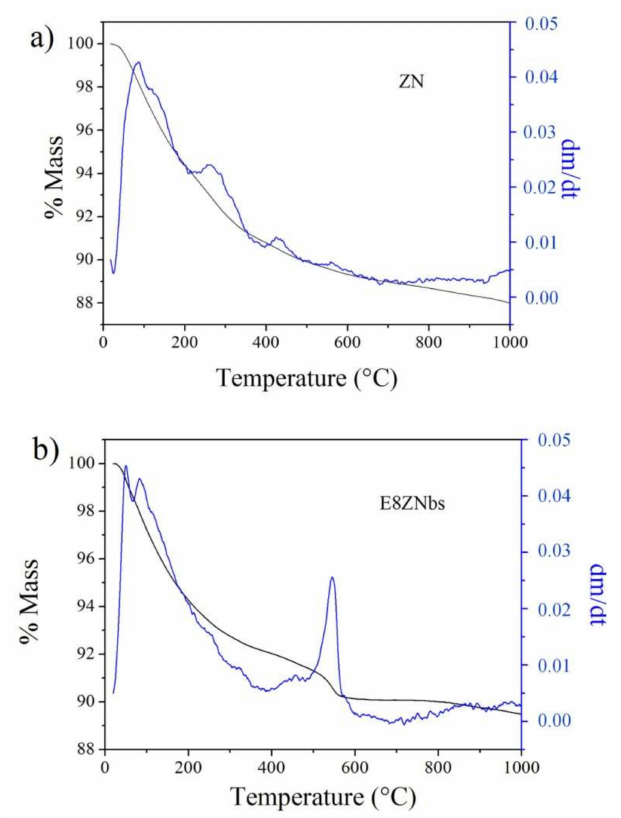
Figure 10. Thermogravimetric analysis of the ( a ) natural sample and the ( b ) E8ZNbs